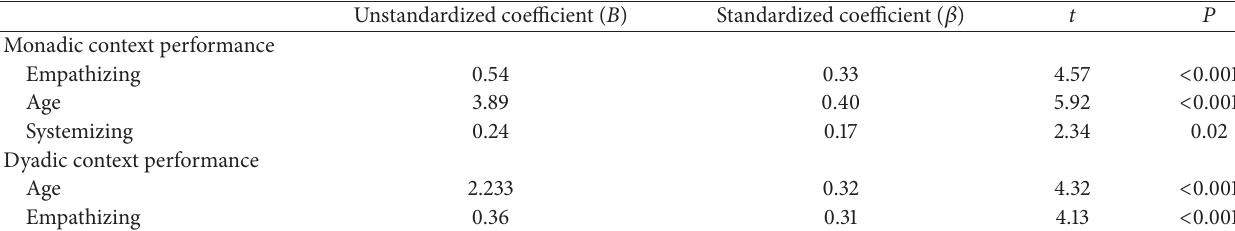
Table 1: Predictors of performance in dyadic and monadic social